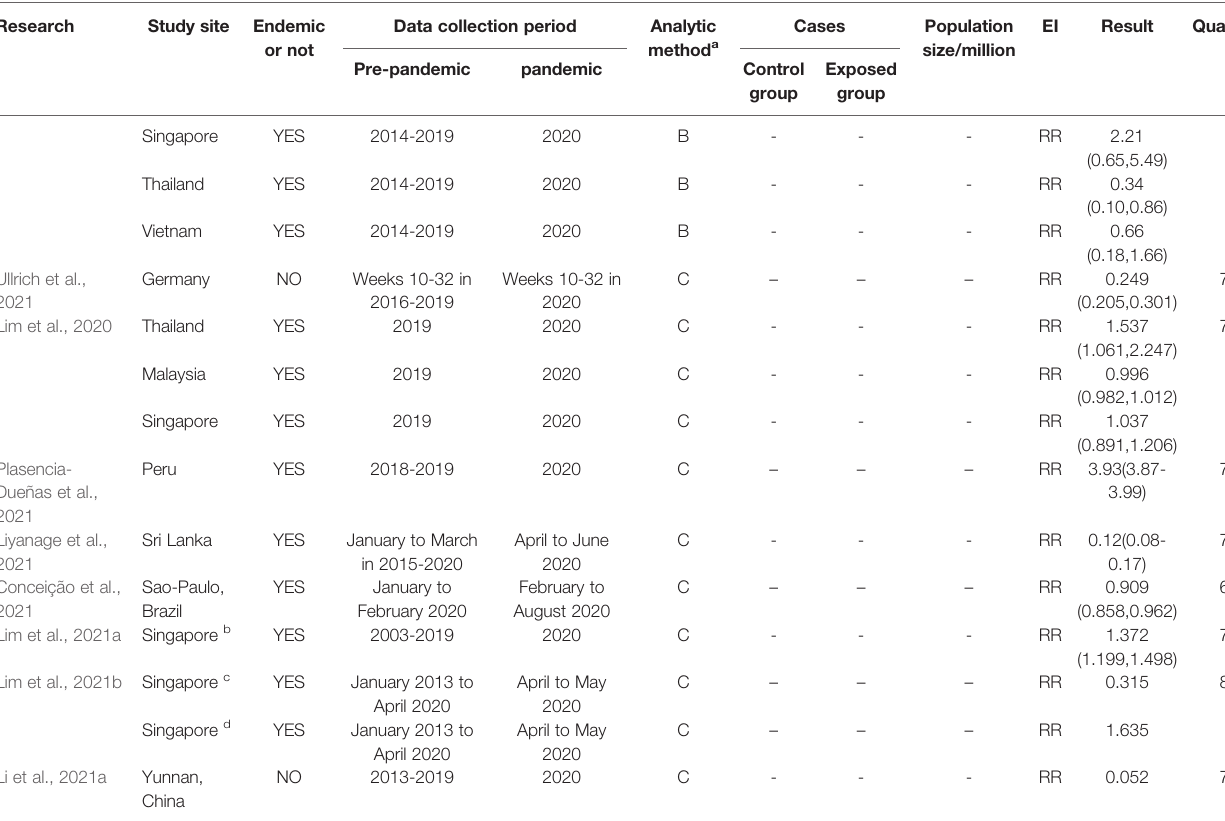
( Figure 2A ). Twenty-nine effect indicator values from